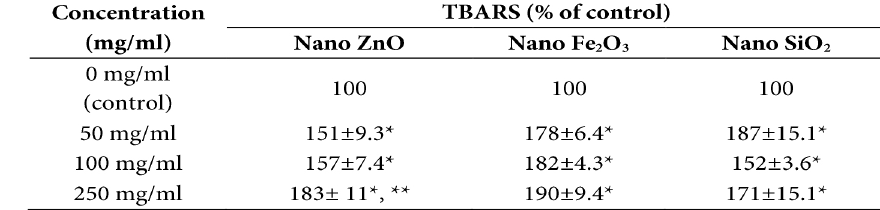
O and SiO 2 3 2